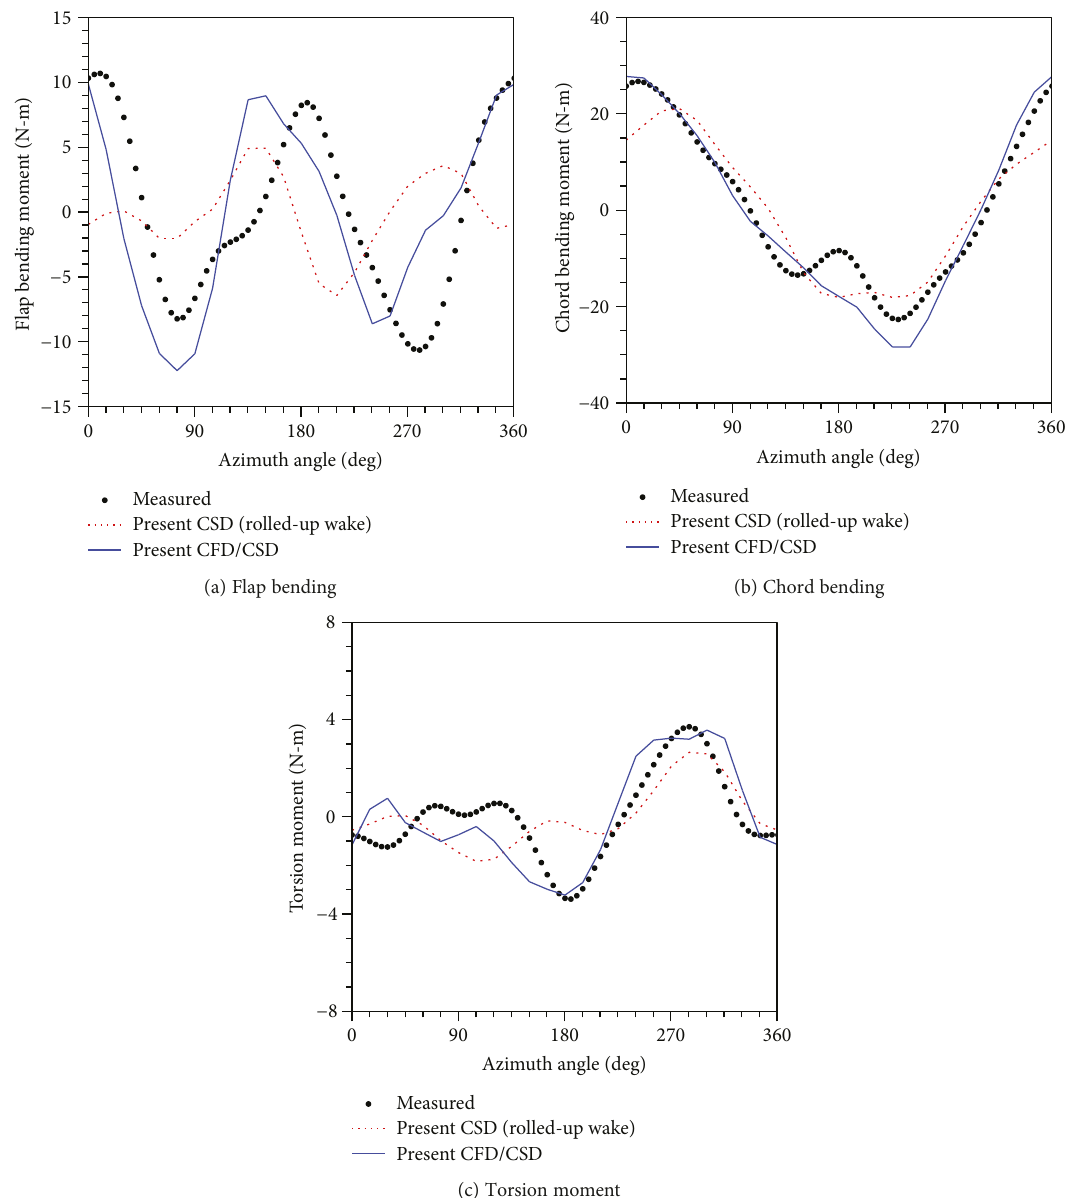
Figure 17: Correlation of structural moments at a blade inboard station r / R =0.144 (mean